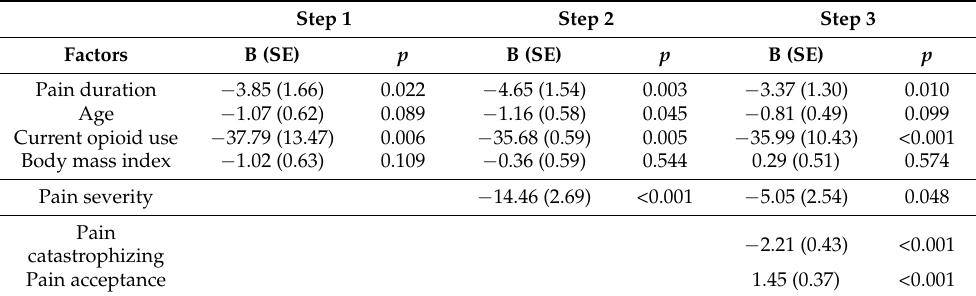
Table 4. Multivariate hierarchical regression predicting performance-based physical